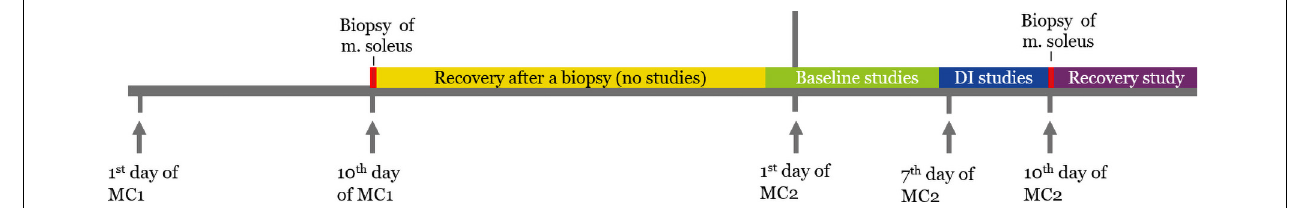
FIGURE 1 | Design of the study of female 3-day Dry Immersion. MC, menstrual cycle; DI, Dry Immersion.